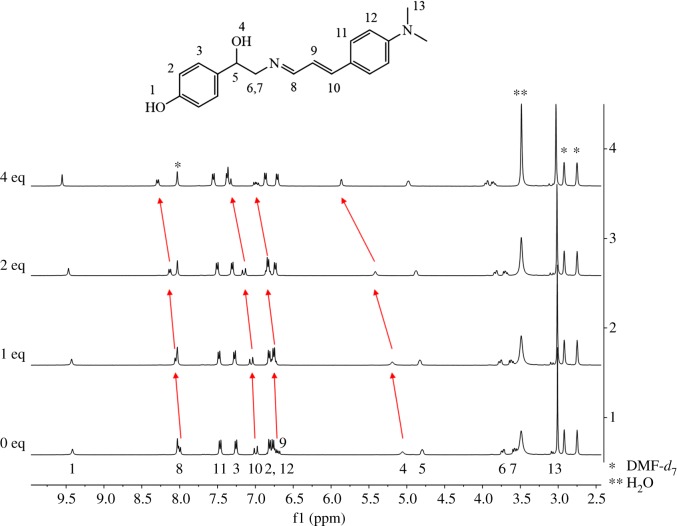
1H NMR titrations of 1 with the addition of Ag+ (0, 1, 2 and 4 equiv).